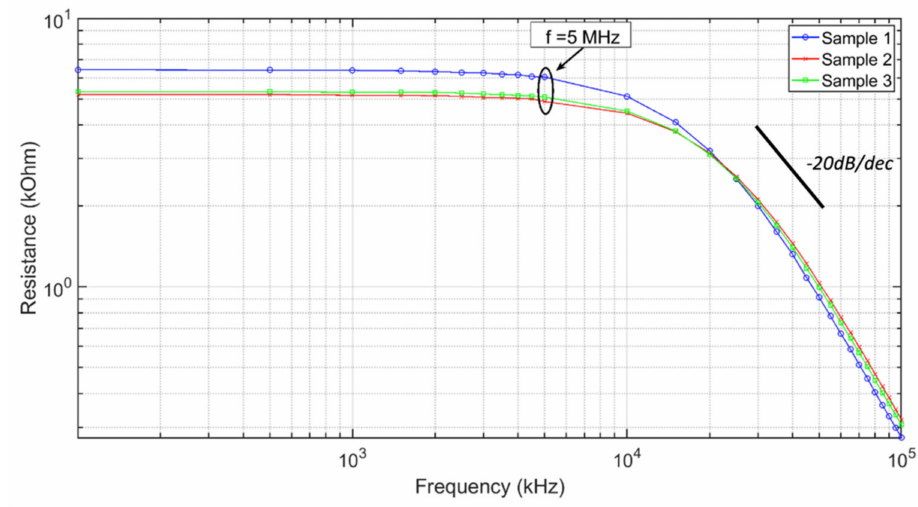
Figure 2. Resistance component of the impedance of three 2.5 cm long polyester samples taken from the same 7.5 cm ECF, measured with the impedance analyzer. The resistance decreased as a function of frequency above 5 MHz at a rate of approximately 20 dB/dec.